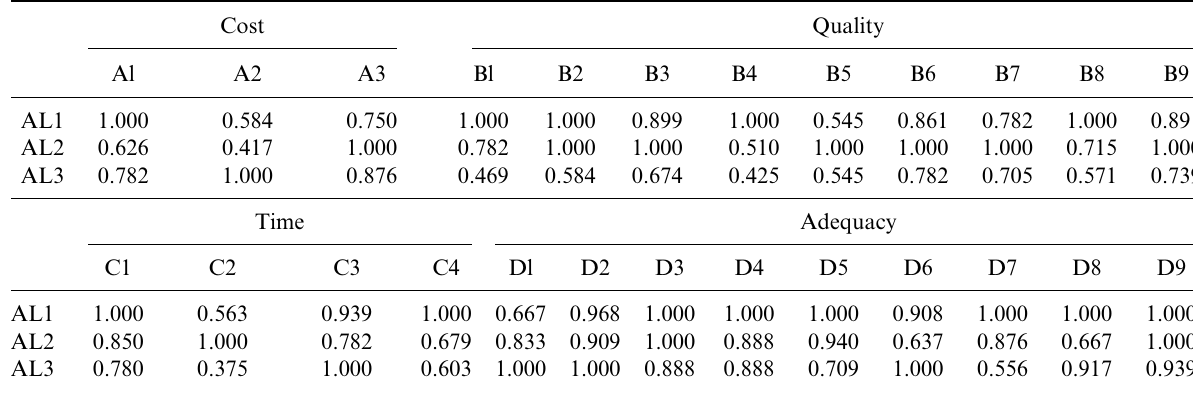
Fig. 3. Scheme of overall preference of attributes Table 4. Normalized decision matrix